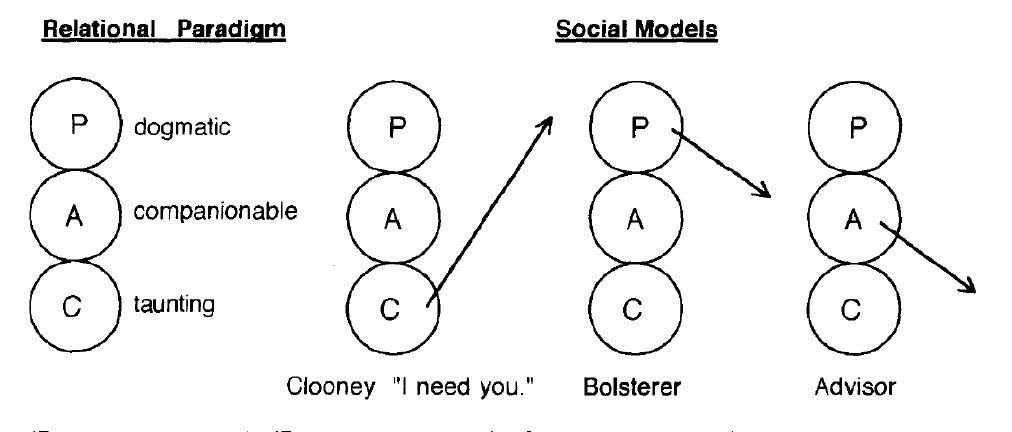
Figure 13: From Relational Paradigm to Social Models (Drego, 1993,